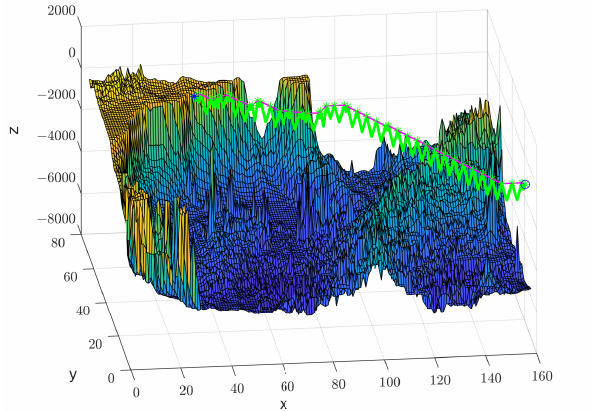
Figure 13. The underwater trajectory from (156,2,0) to (40,61,0) in the three-dimensional marine environment corresponding to the 71 × 158